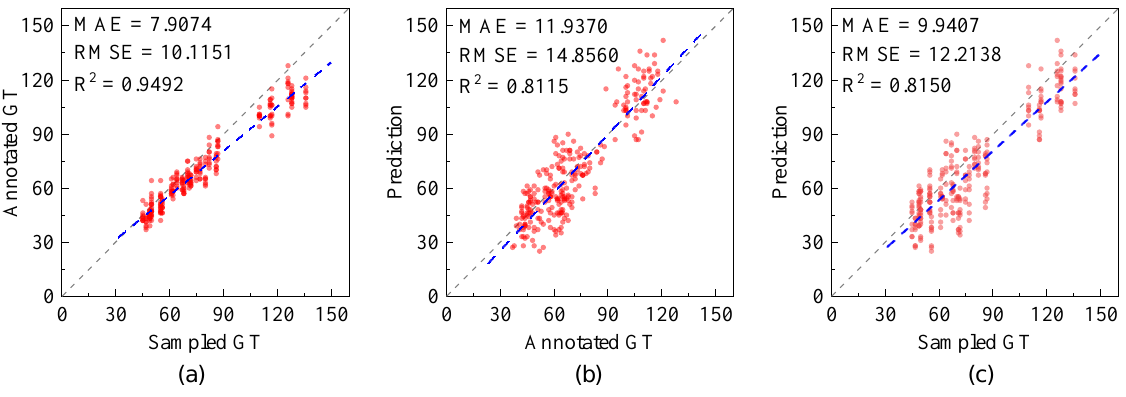
Figure 8. The plant density comparison between ( a ) sampled GT and annotated GT, ( b ) annotated GT and prediction, and ( c ) sampled GT and prediction on the test dataset. GT represents ground-truth.